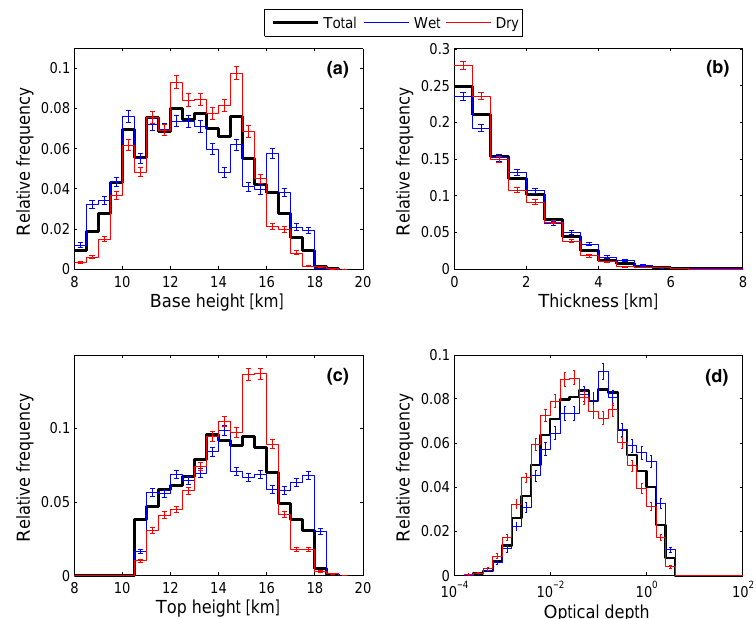
Figure 5. Panels show the normalized histograms of (a) cirrus cloud base, (b) cloud geometrical thickness, (c) cirrus cloud top, and (d) op- tical depth, for the overall period (black), wet season (JFMA, blue), and dry season (JJAS, red). Error bars indicate the counting statistics